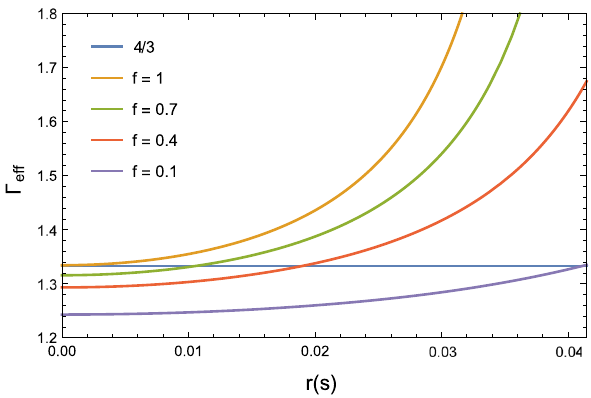
Fig. 5 Effective adiabatic